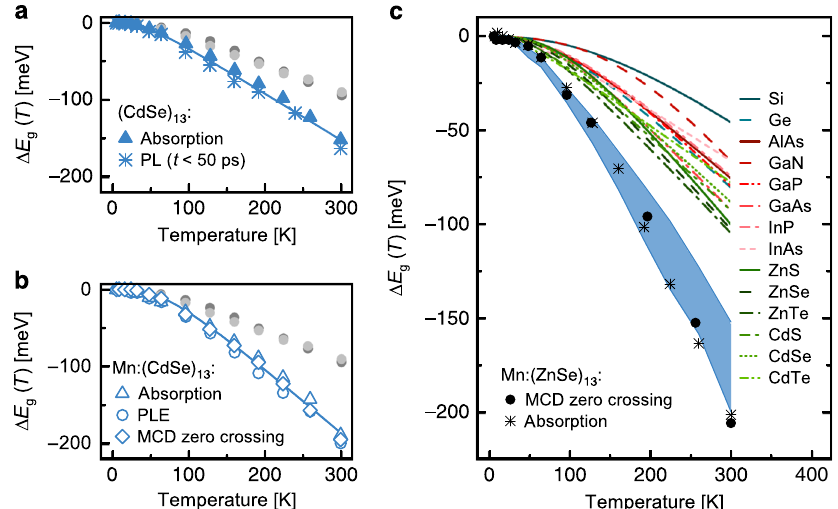
Fig. 2 Giant temperature dependent shift of the bandgap in magic sized cluster (MSC). a , b Comparison of the shift in transition energies from cryogenic to room temperature ( Δ E g ) for undoped ( a ) and Mn 2 + -doped (CdSe) 13 MSCs ( b ) as extracted from different experimental approaches. Data for conventional CdSe (light grey) and CdSe/ZnS (dark grey) quantum dots (QDs) are displayed as dots for comparison (see Supplementary Fig. 3 for the spectra). The peak positions for absorption, photoluminescence (PL) and photoluminescence excitation spectroscopy (PLE) signals are extracted via Gaussian fi ts from the spectra. The peak positions for the energetically lowest magneto-optically active transition are taken from MCD zero-crossings (Fig. 1c). Solid lines represent guides to the eye. c Comparison of the temperature dependence of the band edge transitions for the entity of (CdSe) 13 (blue area) and (ZnSe) 13 MSCs (black symbols) analyzed within this study to some of the most important group IV, III – V, and II – VI semiconductors (data sets are plotted using parametrization following ref. 21 ). The bandgap shifts for Mn 2 + -doped (ZnSe) 13 MSCs are extracted from MCD zero-crossings (black circles) and absorption (black stars) (spectra shown in Supplementary Fig.